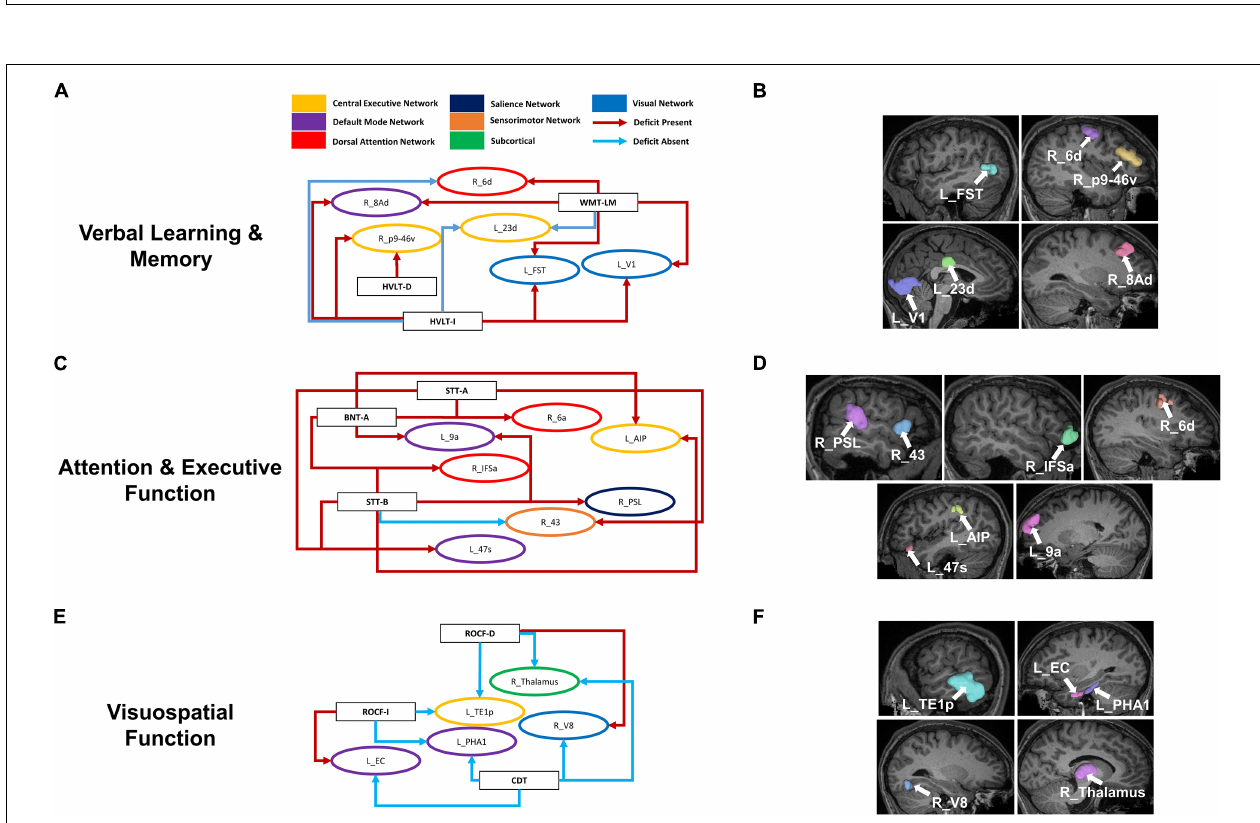
FIGURE 4 | Overlaps within cognitive domains may provide insight into functional compensation and cognitive trajectories in AD. Parcels associated with performance in at least two neurocognitive tests associated within each cognitive domain: Verbal Learning and Memory (A) , Attention and Executive Function (C) , and Visuospatial Function (E) . Each arrow is drawn from the neuropsychological test (rectangle) to a single parcel (oval). The arrows are colored by whether the association was to poor performance (Deficit Present) or good performance (Deficit Absent) as defined in the methodology for each test, while the parcels are colored by their associated networks. Anatomical locations of the given parcels are also shown on a T1 MRI (B,D,F) . BNT-A, Boston Naming Test—Articulateness and Fluency; BNT, Boston Naming Test; HVLT-I, Hopkins Verbal Learning Test—Immediate Memory; HVLT-D, Hopkins Verbal Learning Test—Delayed Recall; ROCF-I, Rey Osterrieth Complex Figure Imitation; ROCF-R, Rey Osterrieth Complex Figure Recall; STT-A, Shape Trail Test—Part A; STT-B, Shape Trail Test Part B, WMS-LM, Wechsler Memory Scale—Logical Memory.